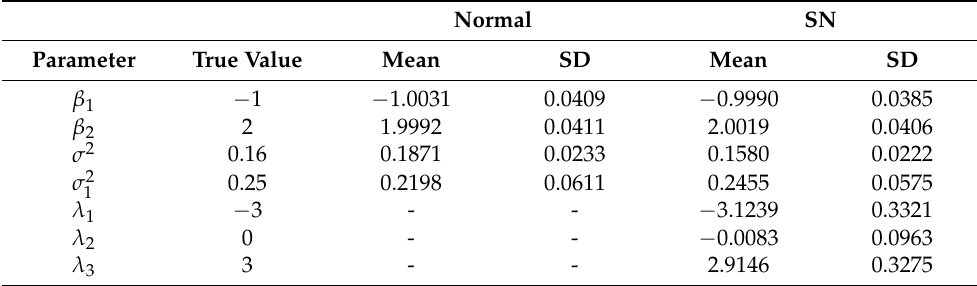
Table 2. Mean and SD of each estimator for both cases with n = 300, σ 2 = 0.4 2 and σ 2